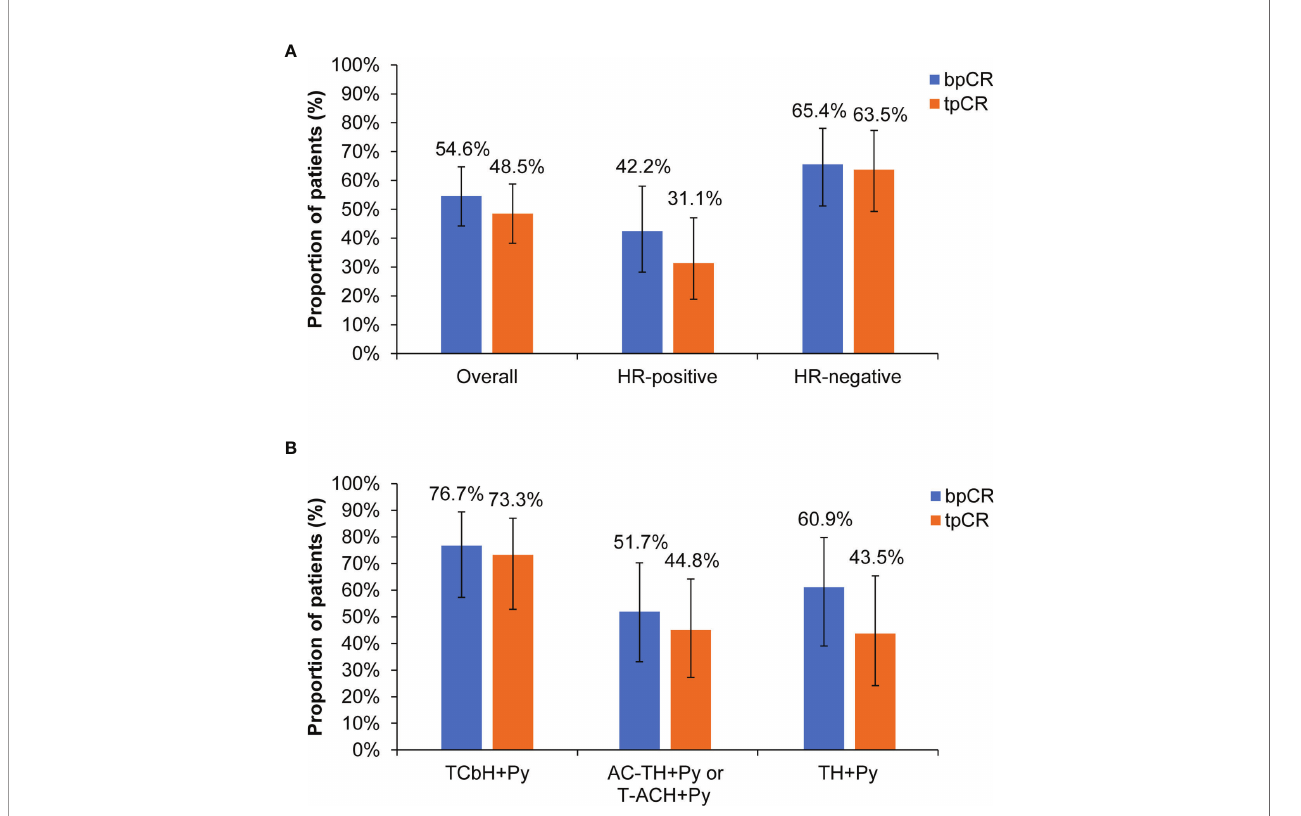
FIGURE 2 | Pathological response. (A) Overall population and subgroups by HR status. (B) Subgroups by different neoadjuvant regimens. bpCR, breast pathological complete response; tpCR, total pathological complete response; HR, hormone receptor; T, taxane (docetaxel, nanoparticle albumin-bound paclitaxel, or paclitaxel); Cb, carboplatin; H, trastuzumab; Py, pyrotinib; A, anthracycline (epirubicin, pirarubicin, or doxorubicin); C,